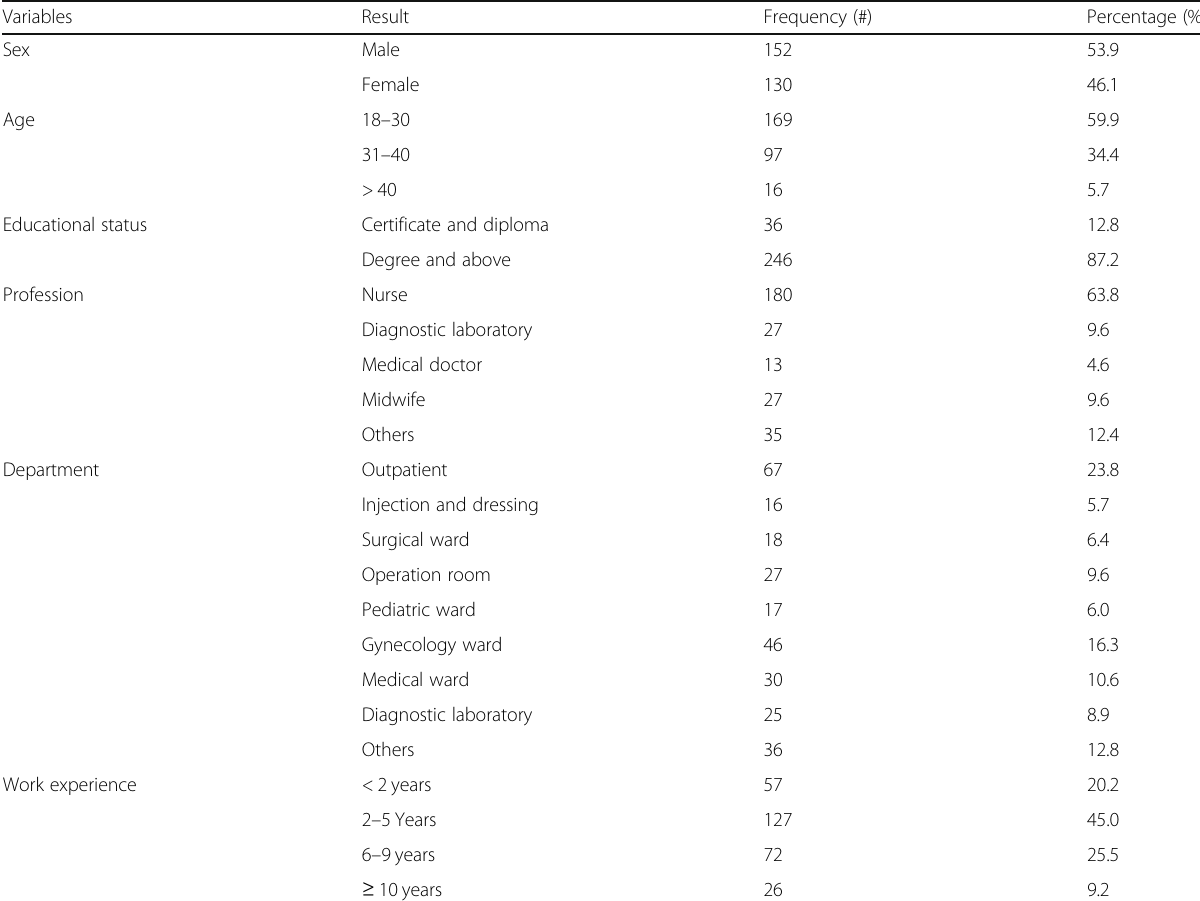
Table 1 socio-demographic characteristics of health care workers